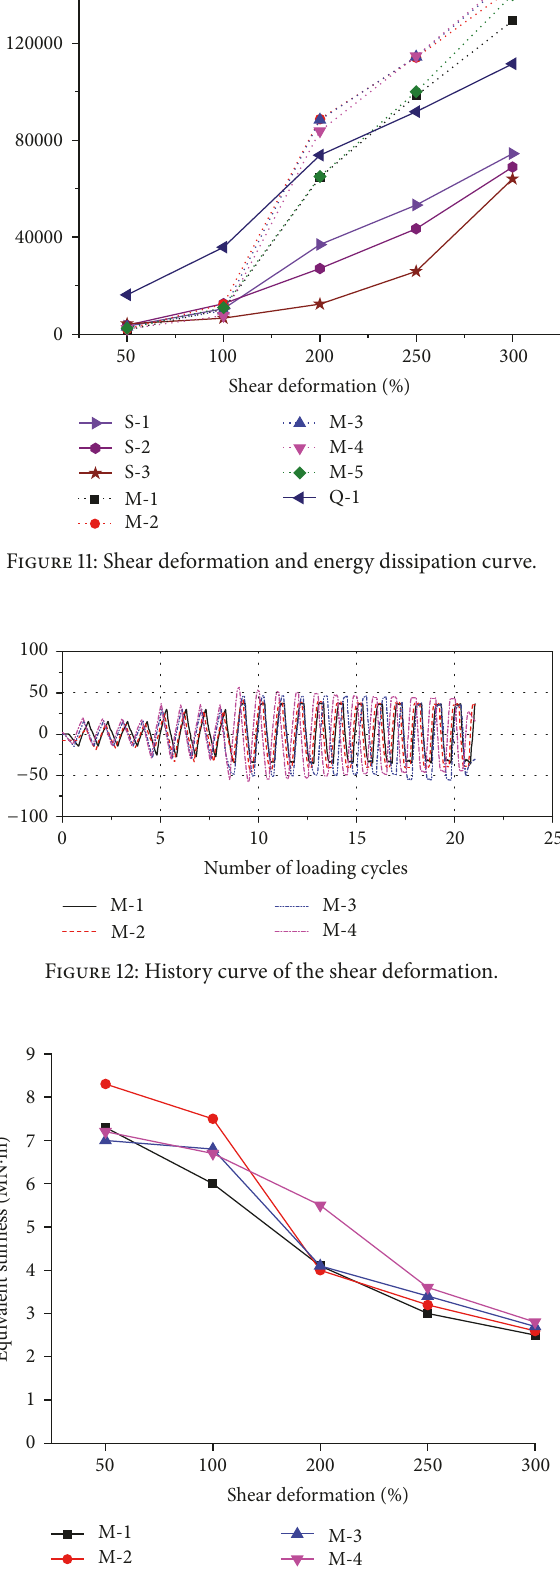
Figure 13: Equivalent stiffness of the bearings under vertical load.